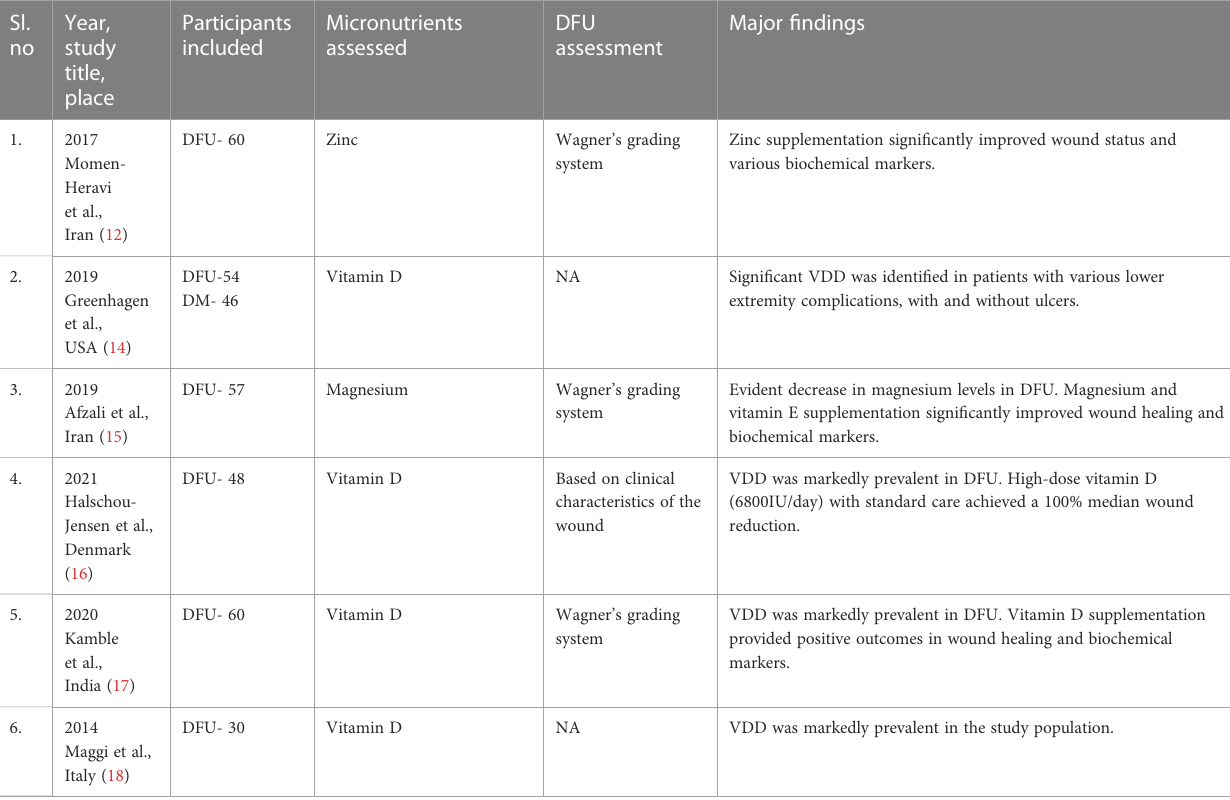
TABLE 1 Study Characteristics.